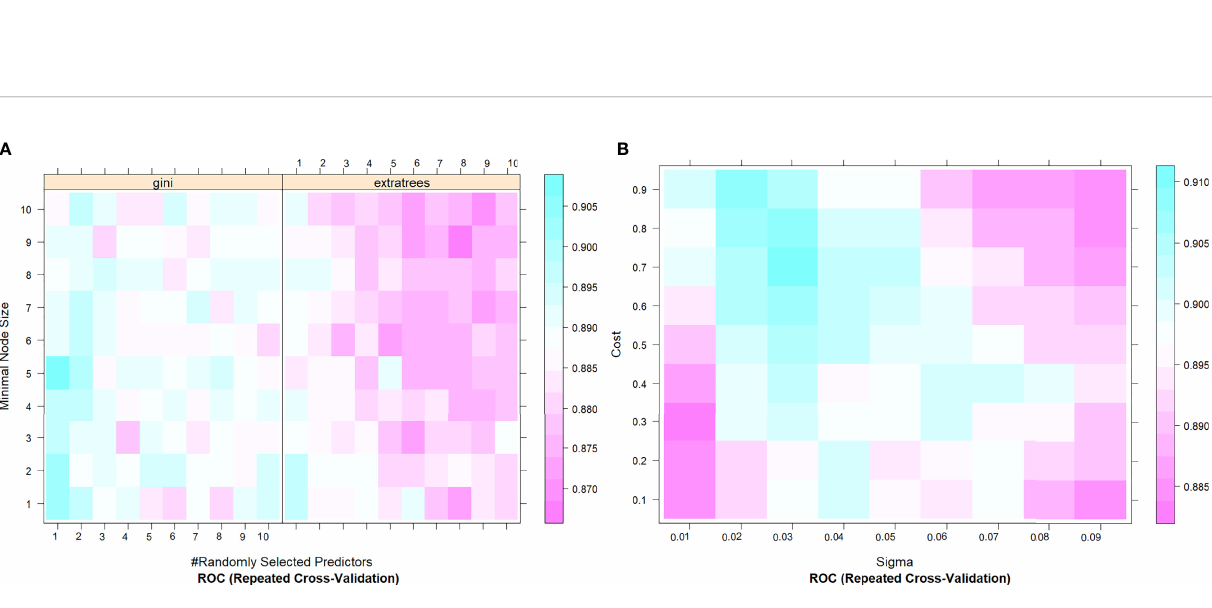
FIGURE 4 | The tuning parameter grid of SVM (A) and RF (B) machine learning classi fi er. The gallery can be used to examine the relationship between the estimates of performance and the tuning parameters. The closer the square color is to blue, the higher the AUC is, while the closer the square color is to red, the lower the AUC value is. AUC, The area under the receiver operating characteristic curve; SVM, Support Vector Machine; RF, Random